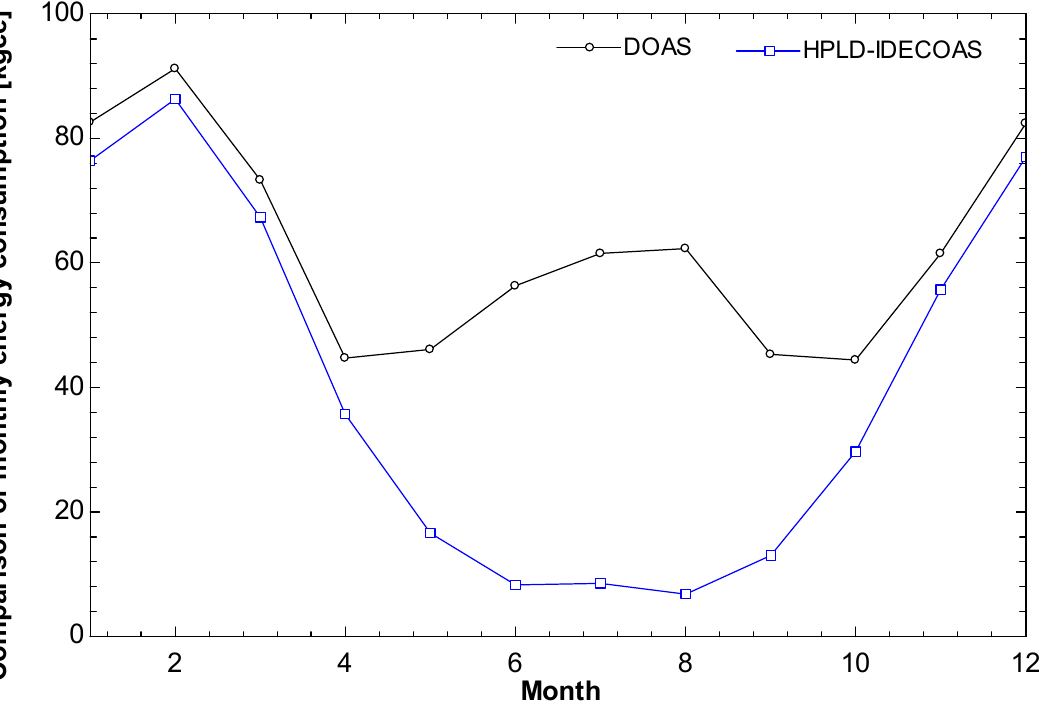
Figure 17. Comparison of monthly energy consumption in Kashi.